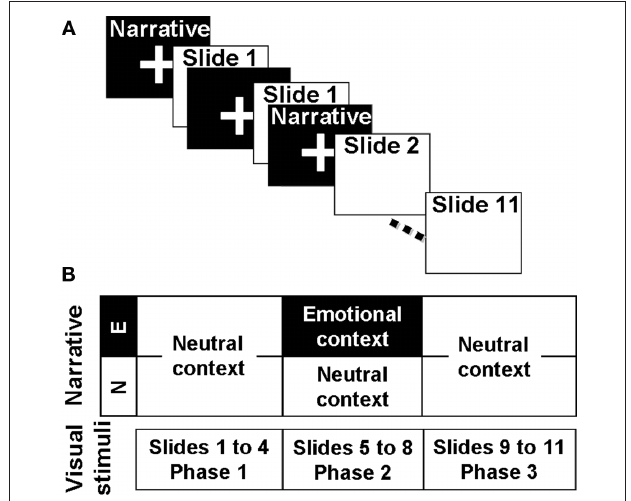
Figure 1 | Schematic representation of the experimental procedure. (A) Slide presentation sequence. Narrative was not concomitant with the slide presentation and preceded the image of the scene it describes. As shown, each slide was presented twice. (B) Auditory and visual material. Images were the same for both versions of the test and were grouped in three phases. The narrative that accompanied the Phase 2 was different for each